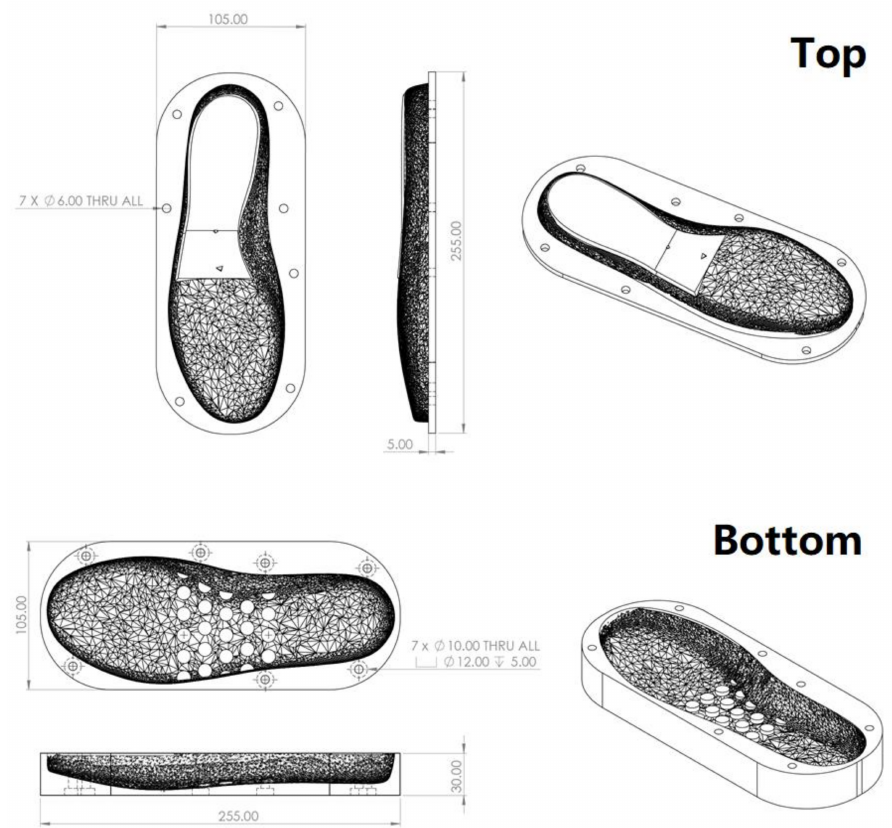
Figure 19. Dimensions of moulds used to produce SMH sole (size: 37.5; left